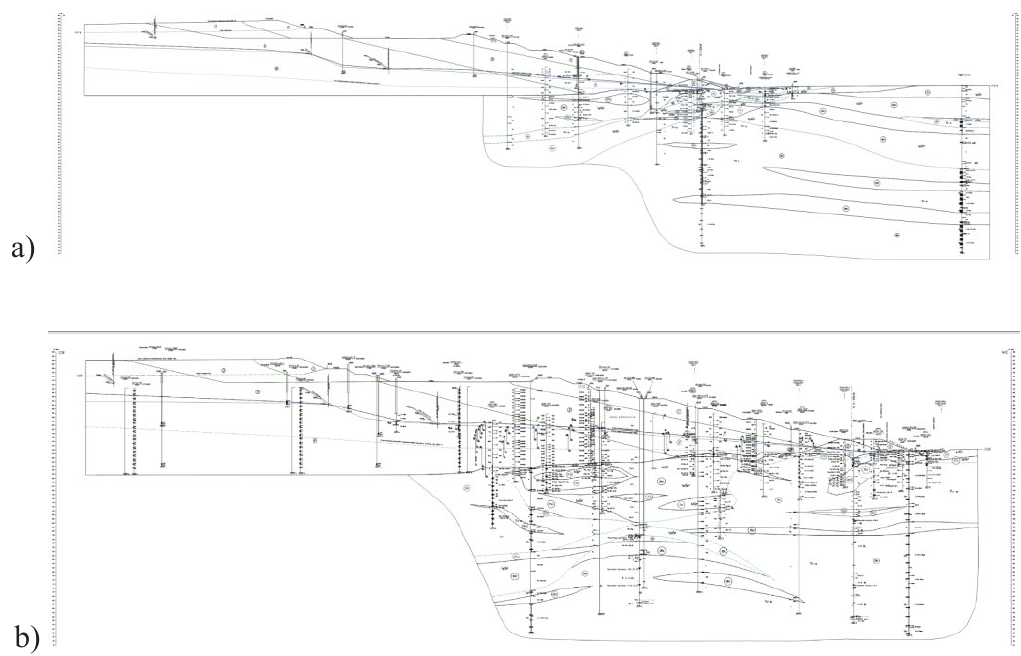
Figure 5: Geotechnical cross-sections along the boreholes located in a) cross-section VIIIN and b) cross-section